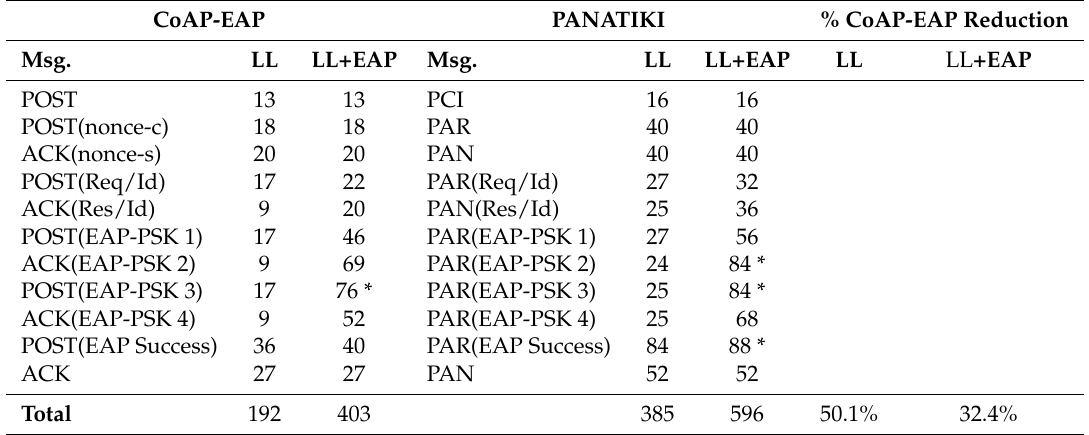
Table 2. Message